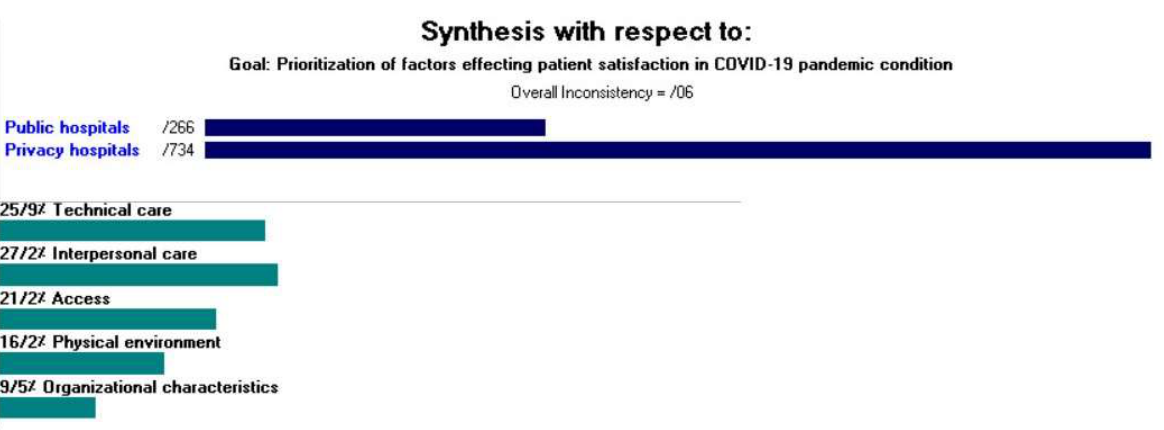
Figure 2. The AHP weights of criteria.